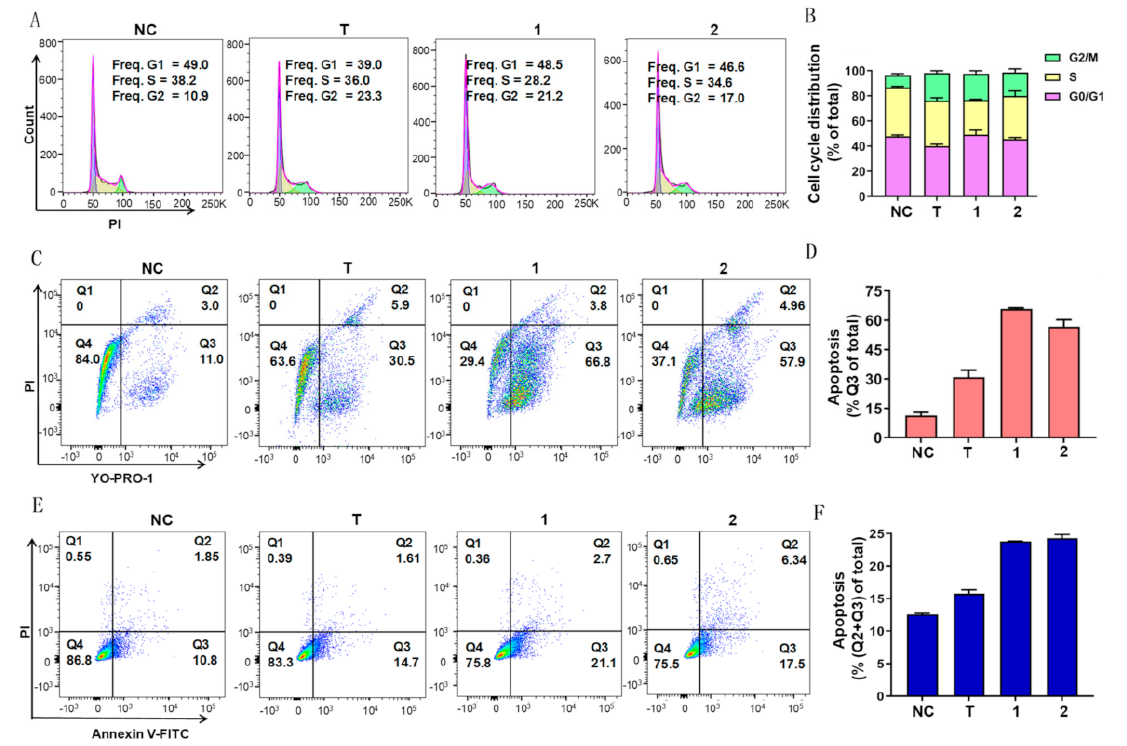
Figure 7. Effects of toluquinol and its derived metabolites 1 – 2 on cell cycle, apoptosis, and necrosis of non-small lung cancer cell A549. ( A , B ) Analysis of A549 cell cycle distributions with flow cytometry and PI staining. ( C , D ) Apoptosis and necrosis analysis of A549 with flow cytometry and YO-PRO- 1/PI staining. The apoptotic cells were YO-PRO-1 positive (gate Q3), and the necrotic cells were both YO-PRO-1 and PI positive (gate Q2). ( E , F ) Apoptosis analysis of A549 with AnnexinV-FITC/PI staining. The early apoptotic cells were AnnexinV-FITC positive (gate Q3), and late apoptotic cells were both AnnexinV-FITC and PI positive (gate Q2). Negative control: NC; T: